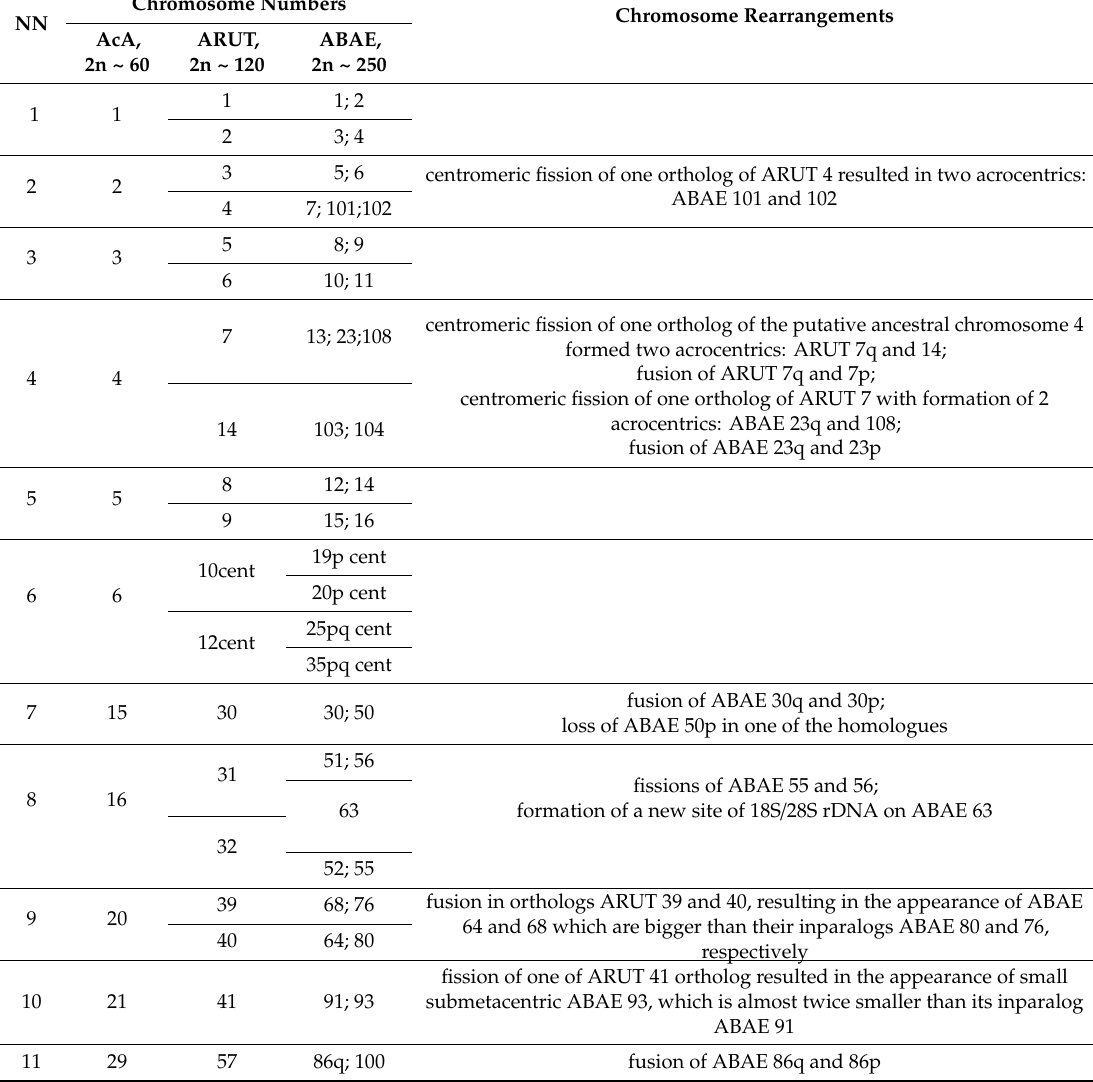
Table 2. Correspondence between some chromosomes of the proposed ancestor (AcA), Acipenser ruthenus , and Acipenser baerii and putative chromosomal reorganizations in both